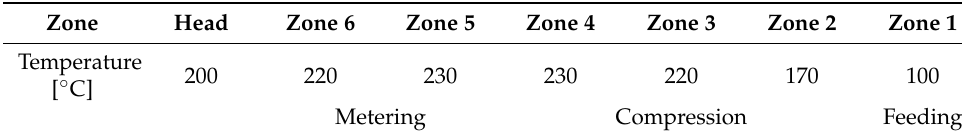
Figure 1. Comparison of polyolefins before ( left ) and after ( right ) homogenization treatment. Table 1. Temperature profile for the extrusion treatment.